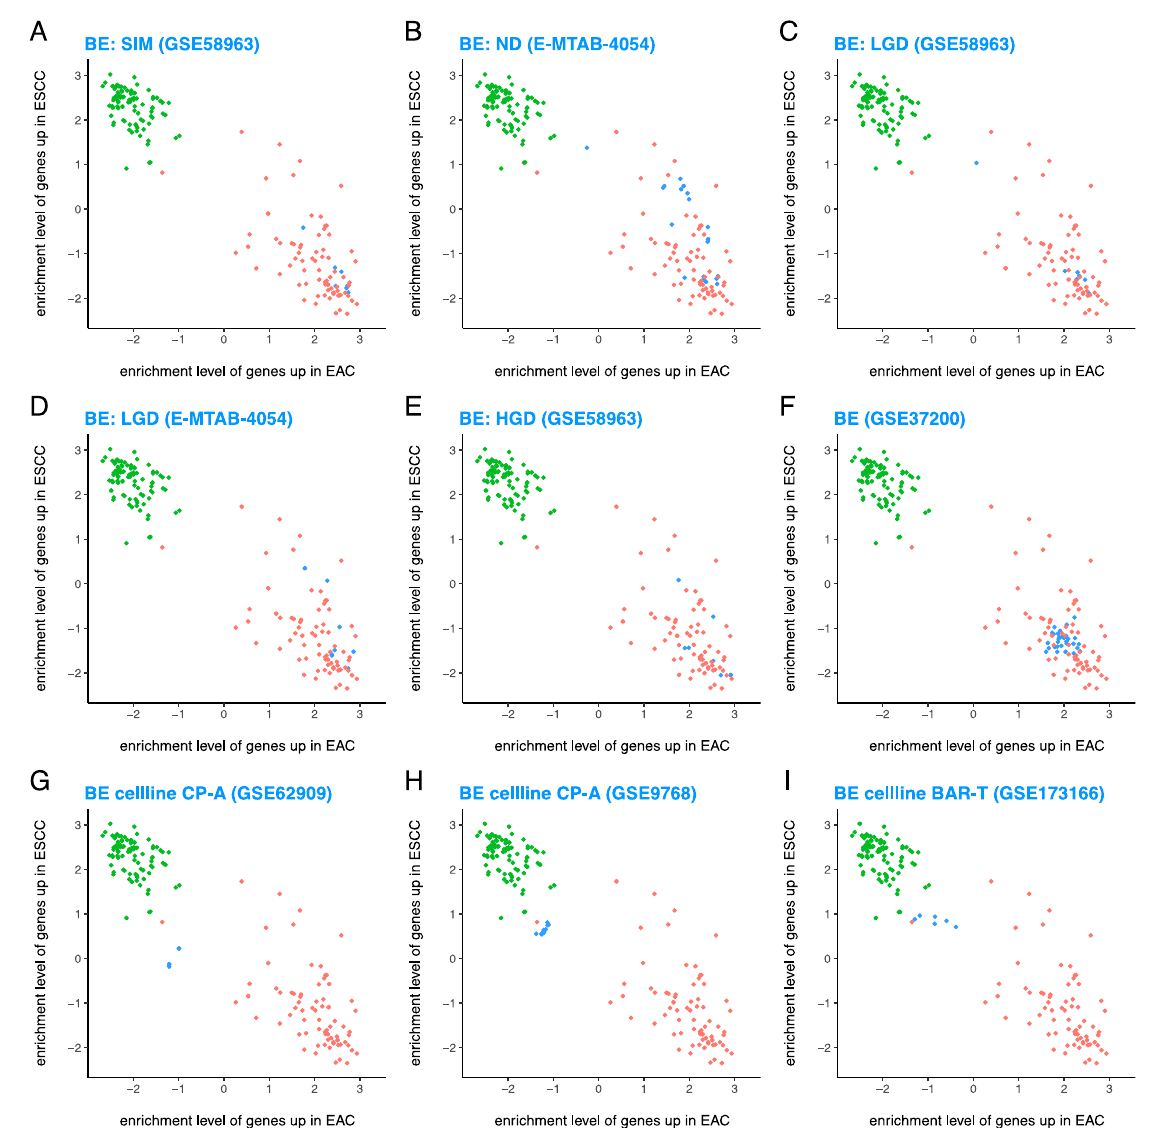
Figure 4. Barrett’s esophagus (BE) cell lines were ESCC-like and extremely different from EAC-like primary BE tissues. Enrichment levels of 100 EAC hi and 100 ESCC hi genes show that ( A – F ) primary BE tissues are EAC-like at all stages (SIM = specialized intestinal metaplasia, ND = non-dysplastic, LGD = low grade dysplasia, and HGD = high grade dysplasia), and ( G – I ) BE cell lines (CP-A, BAR-T) are surprisingly ESCC-like, and extremely different from primary BE tissues. Red = EAC cases from TCGA, green = ESCC cases from TCGA, and blue = test samples (various types of samples from datasets other than